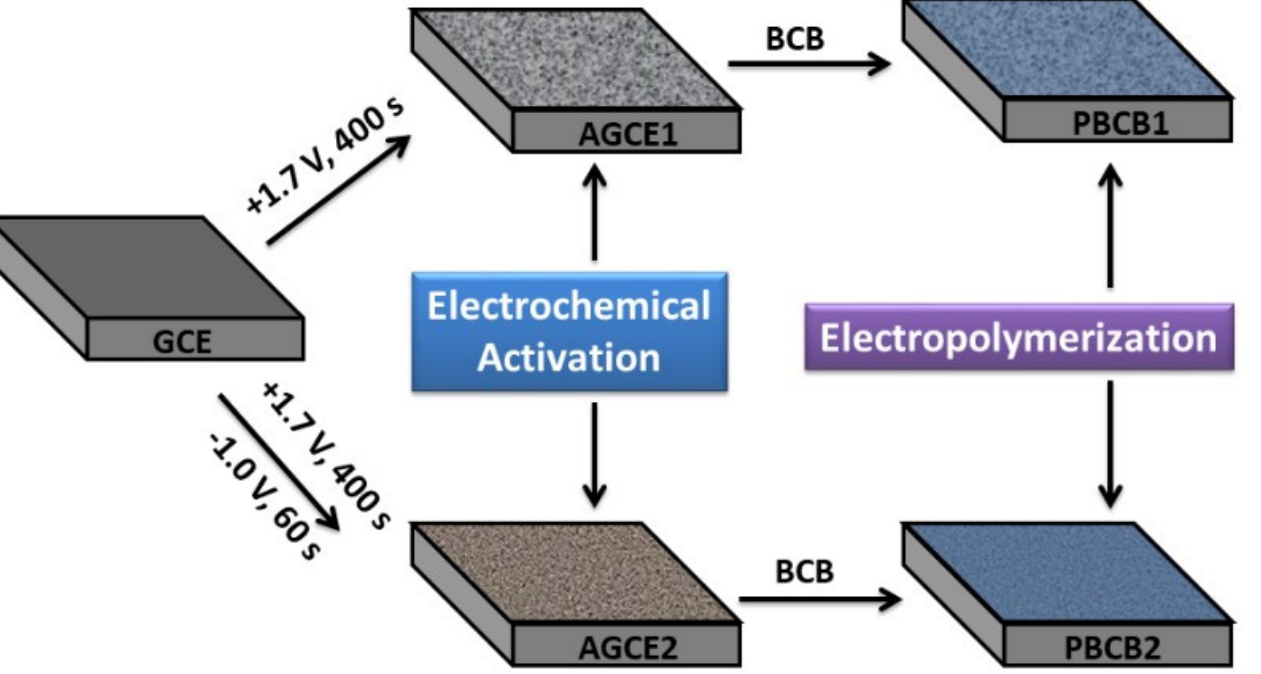
Scheme 1. Schematic representation of the modification of PBCB1 and PBCB2 for the simultaneous determination of HQ and